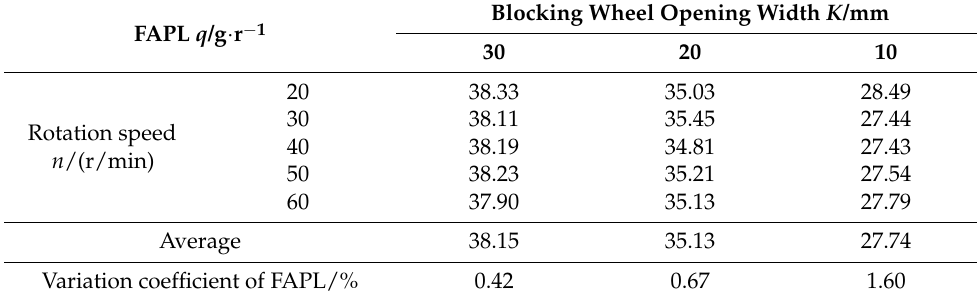
Table 8. Results of FAPL determination tests.